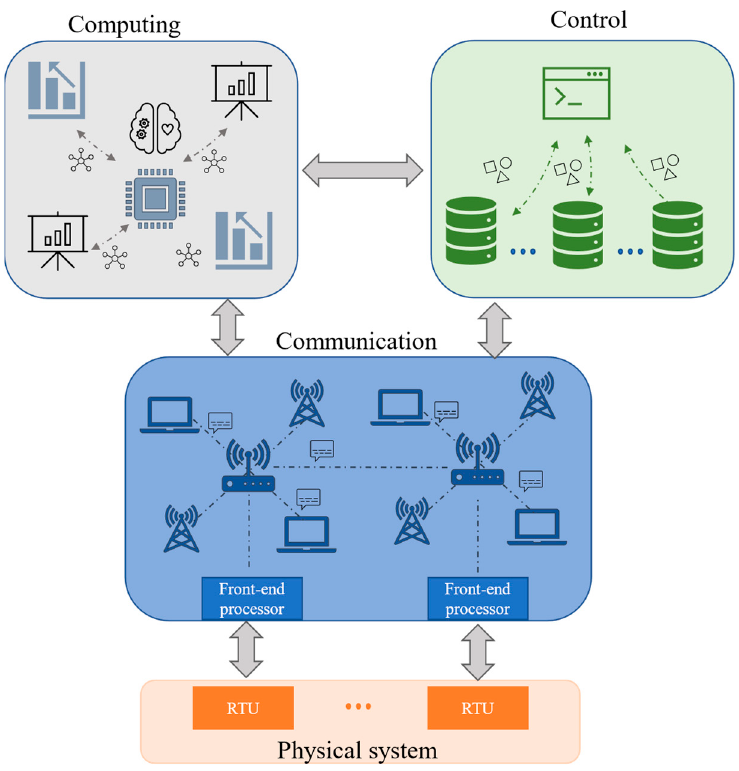
Figure 3. Framework of cyber system.